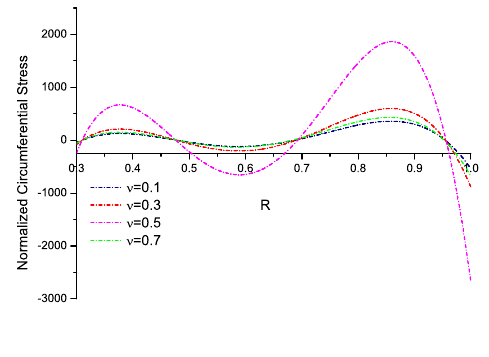
Figure 10: Variation of normalized circumferential stress with Pois- son’s